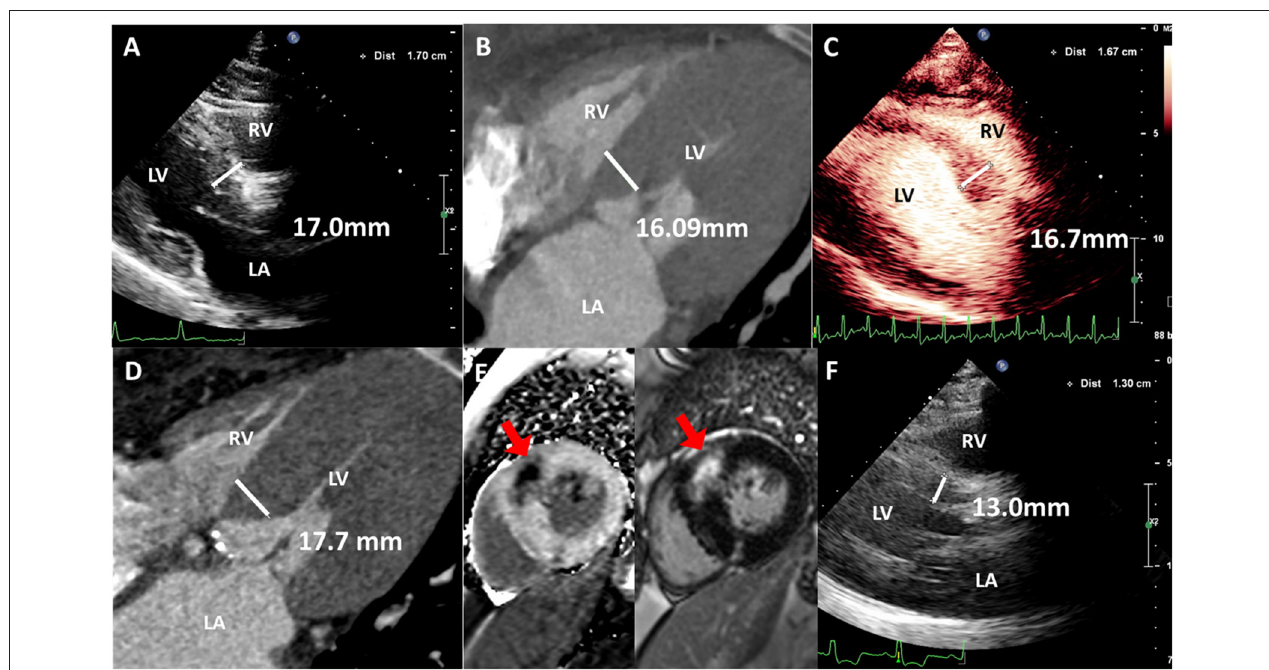
FIGURE 2 | Imaging characteristics of interventricular septa. (A) Thickened interventricular septa was confirmed by TTE of 17.0mm. (B) Thickened interventricular septa was confirmed by CT of 16.09mm. (C) Left ventricular contrast echocardiography shows thickened interventricular septa of 16.7mm at 6-month follow-up after TAVR. (D) Thickened interventricular septa was confirmed by CT of 17.7mm at 6-month follow-up after TAVR. (E) Myocardial fibrosis and delayed enhancement was confirmed by cardiac magnetic resonance. (F) Interventricular septal thickness decreased to 13.0mm after PIMSRA 5 days later. Red arrows: delayed enhancement.